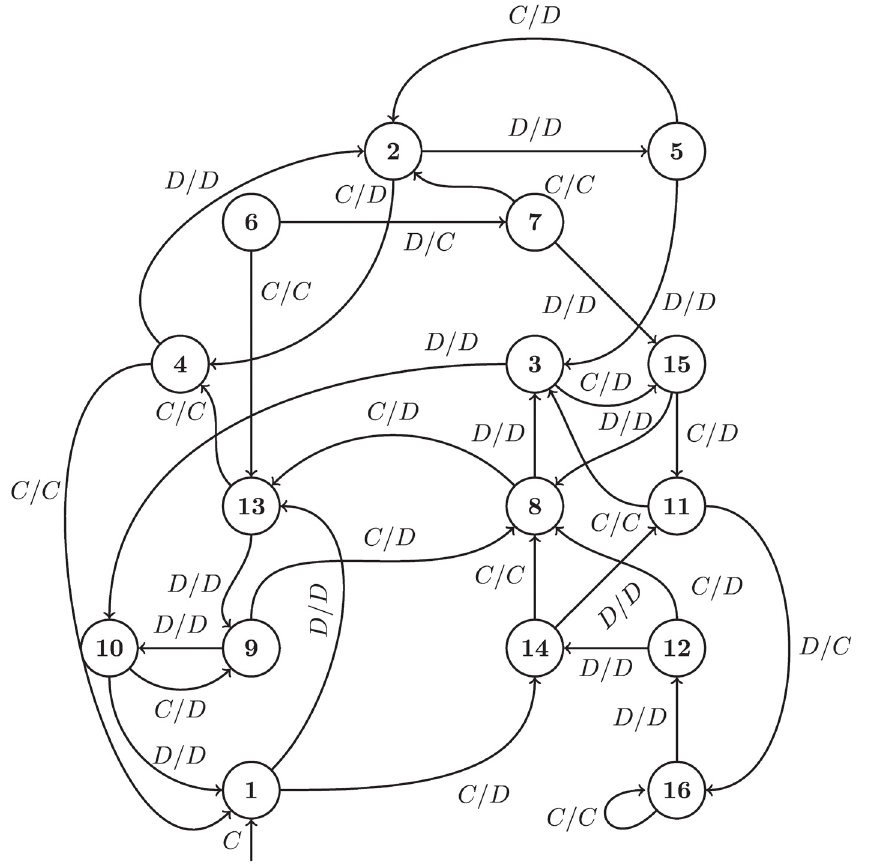
Fig 3. TF2: A 16 state finite state machine with a handshake leading to mutual cooperation at state 16.